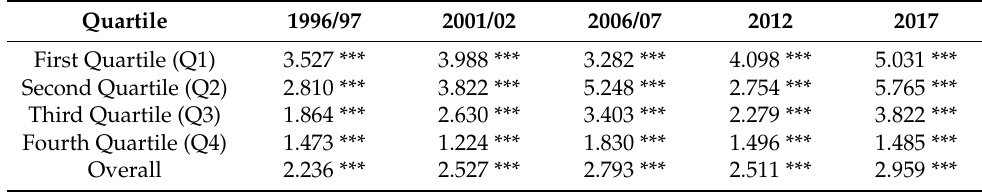
Table 4. Summary of Income Elasticity of OOPHE from the Tobit Models.